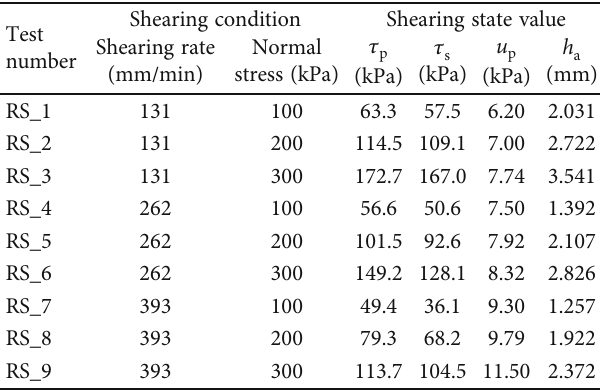
Table 3: Summary of ring shear test